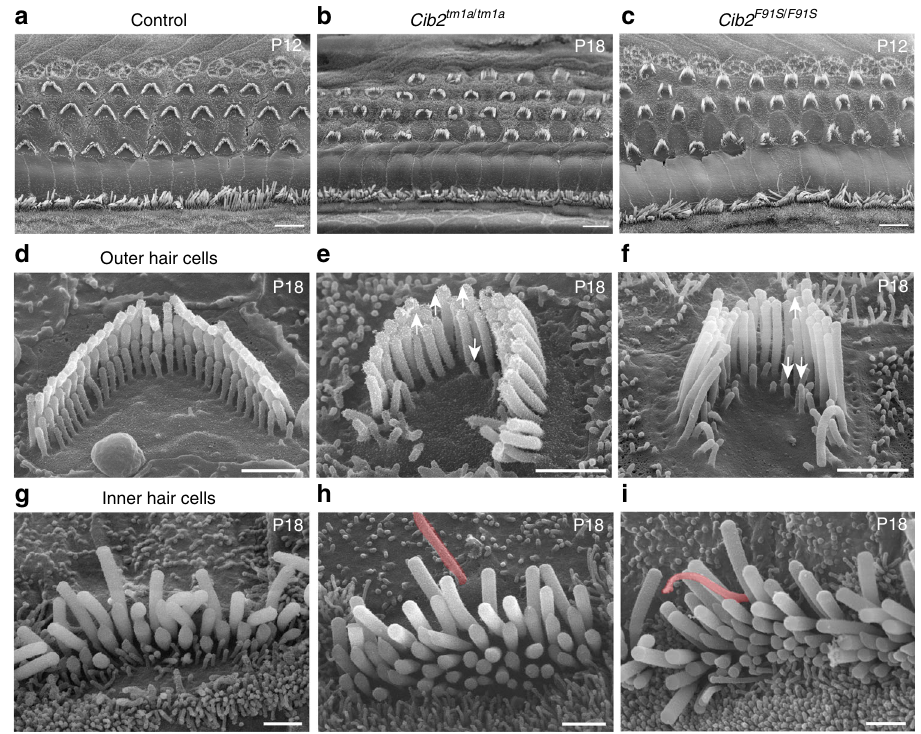
Fig. 3 CIB2 de fi ciency disrupts stereocilia bundle morphology of the auditory hair cells. SEM images of the organs of Corti ( a – c ), as well as OHC ( d – f ) and IHC ( g – i ) stereocilia bundles from control heterozygous ( a , d , g ), Cib2 tm1a/tm1a ( b , e , h ), and Cib2 F91S/F91S ( c , f , i ) mice at the mid-cochlear location. Over-grown and retracted stereocilia are shown by arrows up and down , respectively. The IHC kinocilium does not regress properly in Cib2 mutant mice ( pink ). Scale bars: a – c 5 µ m, ( d – i ) 1 µ